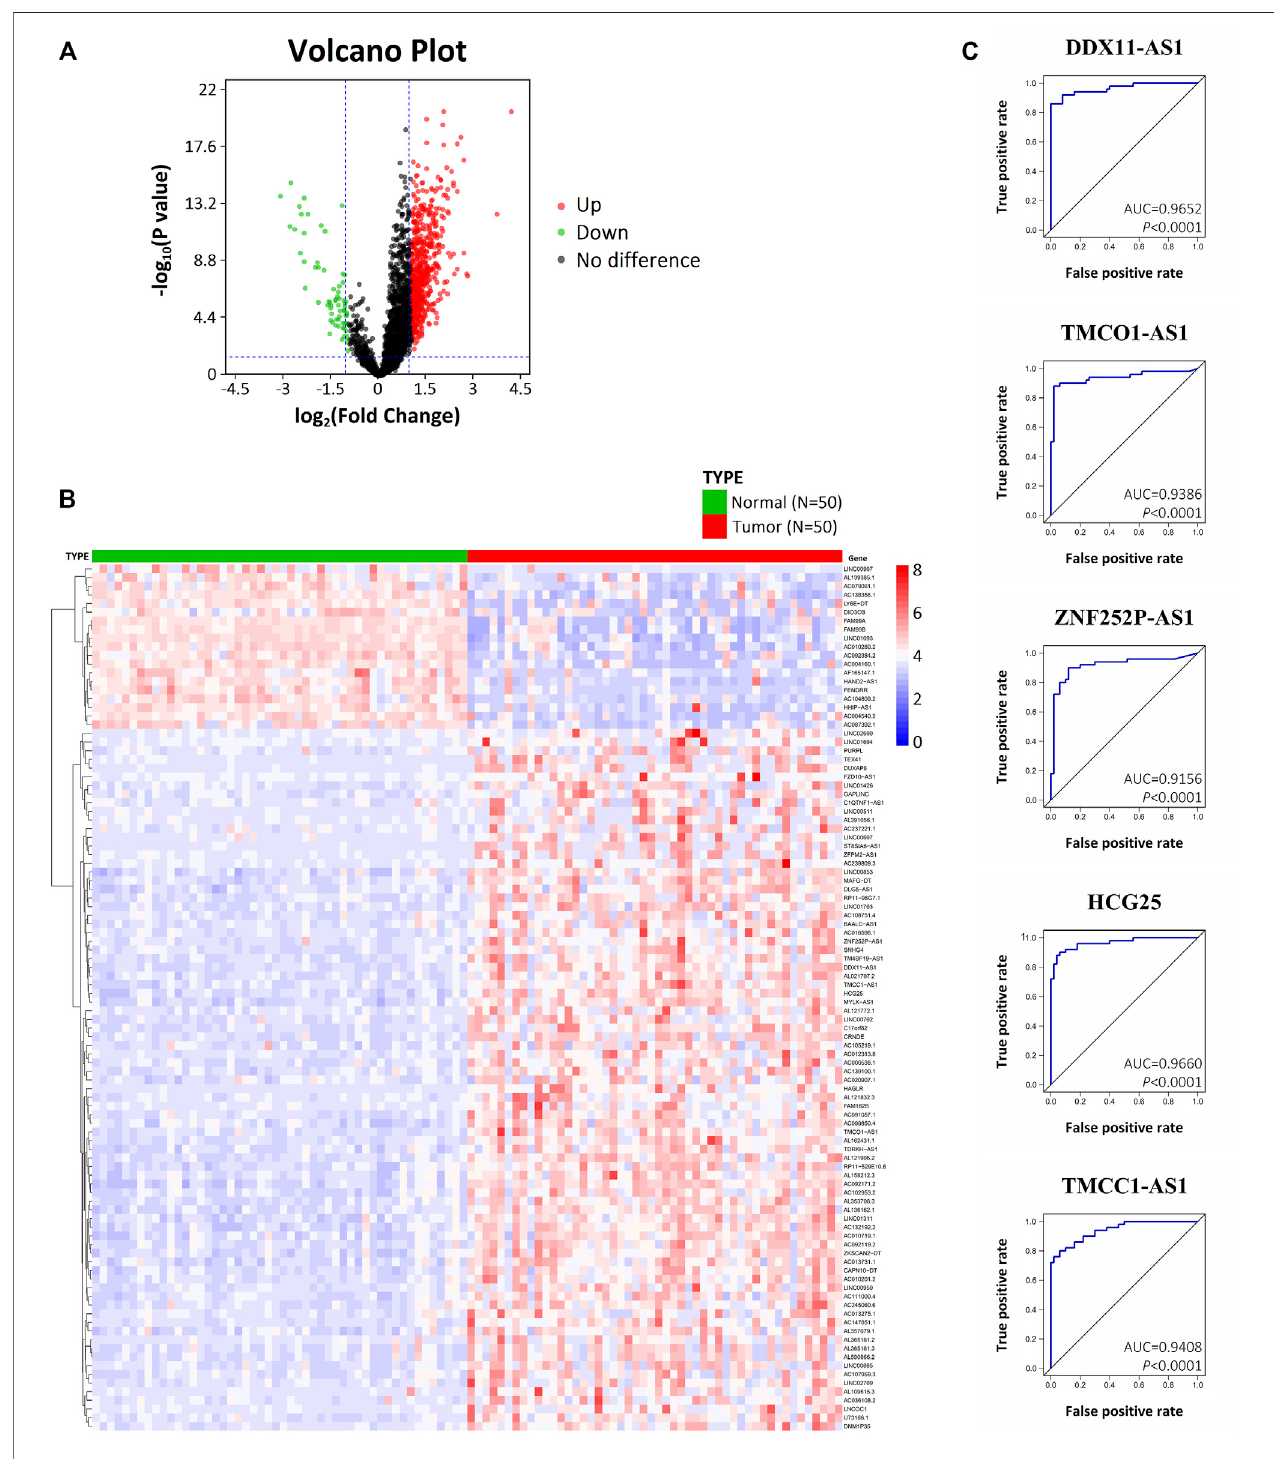
FIGURE 1 | Differentially expressed lncRNAs in HCC based on bioinformatics analysis of TCGA. (A) Volcano plot illustrating the DElncRNAs between HCC tissues andadjacentnormaltissues. (B) Heatmapshowingthehierarchicalclusteringofthetop100DElncRNAs. (C) ROCcurvesof fi veDElncRNAs(DDX11-AS1,TMCO1-AS1, ZNF252P-AS1, HCG25, TMCC1-AS1) with an AUC > .9.